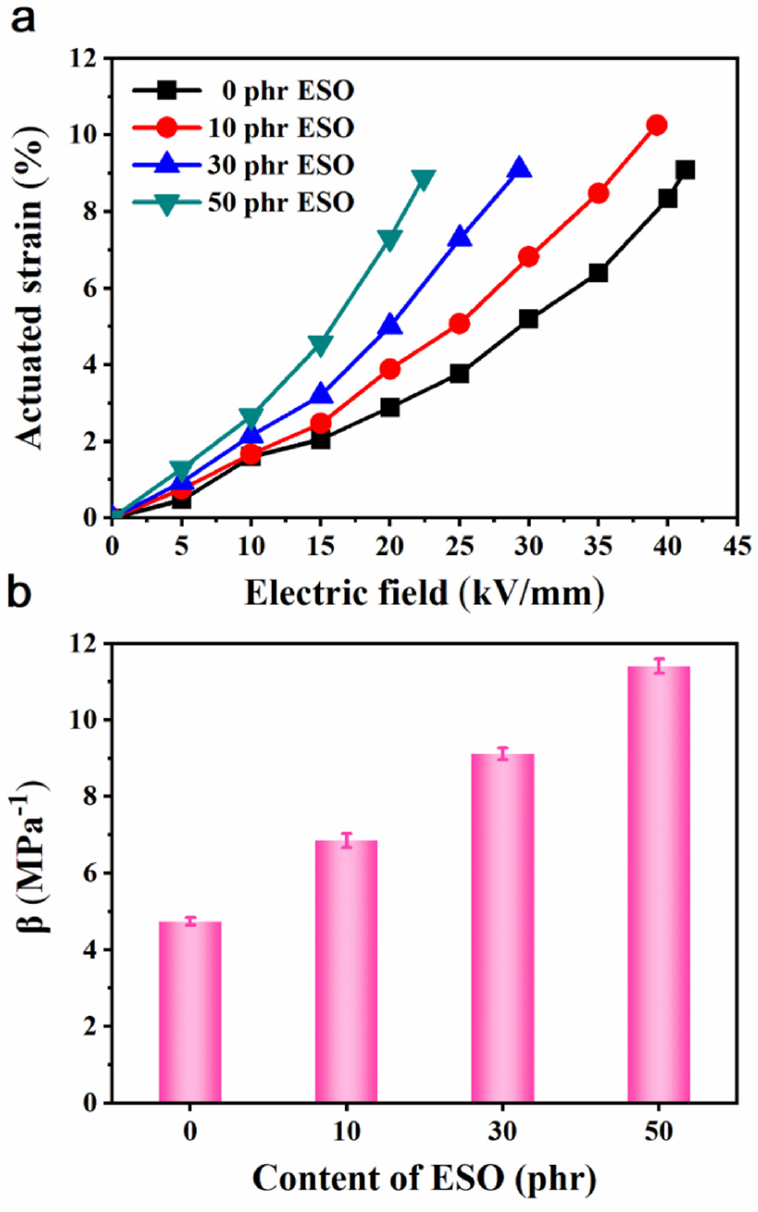
Figure 10. ( a ) Actuated strains and ( b ) β of Si747@BTO/ENR composites with various loadings of ESO.